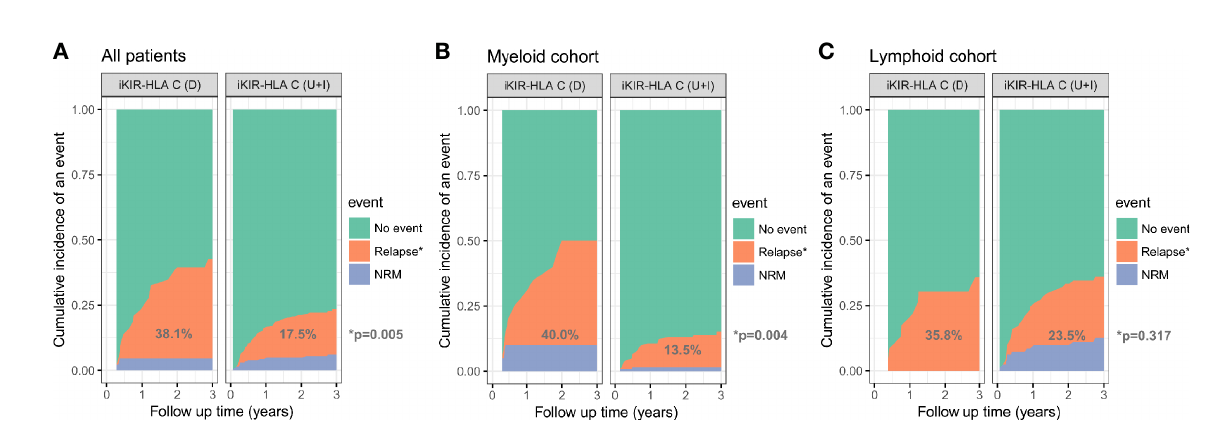
FIGURE 1 | Cumulative incidence of relapse among all patients (A) , the myeloid cohort (B) , and the lymphoid cohort (C) , based on the variation (D, decreased; U, unchanged; I, increased) in iKIR-HLA C pair